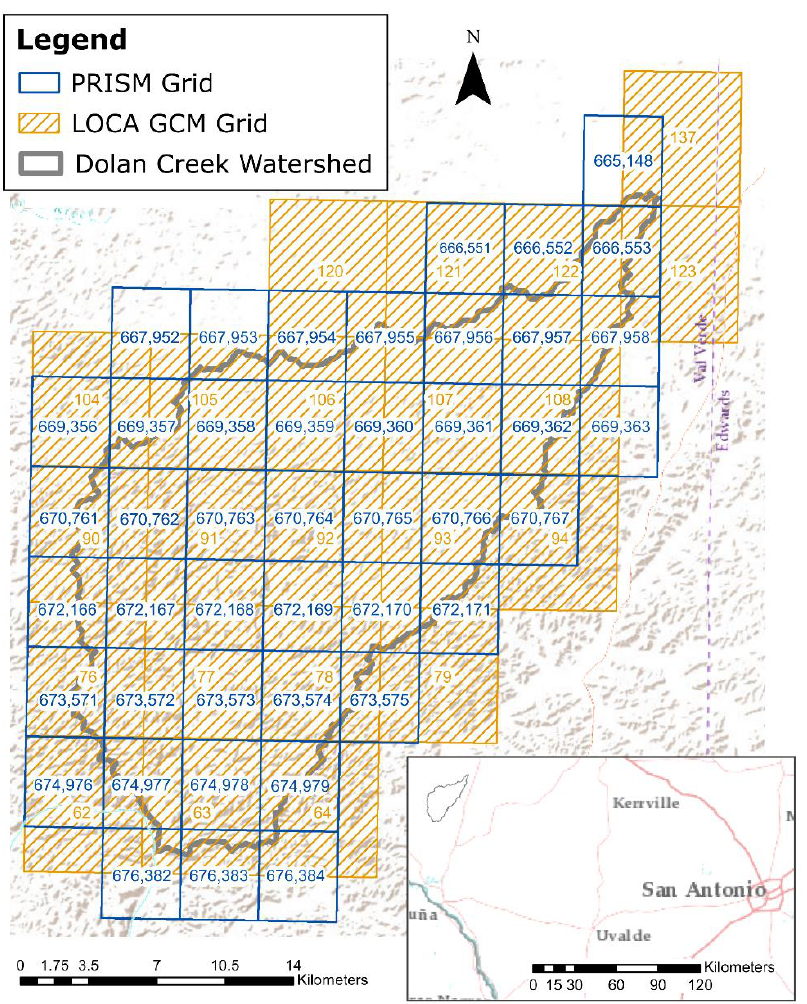
Figure 1. Site watershed location and comparison of PRISM and downscaled, ensemble GCM simulation (LOCA) weather parameter grids. The label for each grid cell, used in this study, is displayed in the center of the cell. PRISM grid and labels are in blue; “LOCA Archive” grid and labels are in orange. Grid index numbering for LOCA and PRISM is the numbering used in this study and is not a reference identifier. The site watershed is northwest of San Antonio, TX, USA.